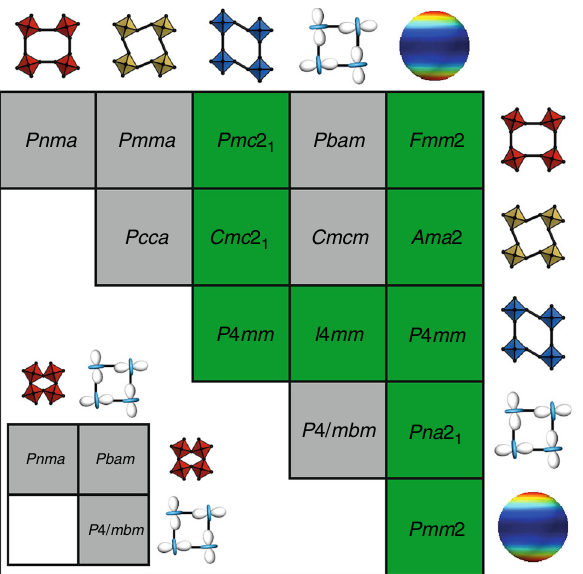
Fig. 2 Coupling schemes in molecular perovskites. The accessible distortion types are given at the top of each column and the right of each row: conventional tilts, unconventional tilts, columnar shifts, Jahn – Teller distortions, and multipole ordering. For each combination of distortions, a representative space group is shown and the colour indicates whether coupling of the two distortions can ever drive a polar distortion (green) or not (grey). The inset shows the corresponding coupling scheme for conventional inorganic perovskites